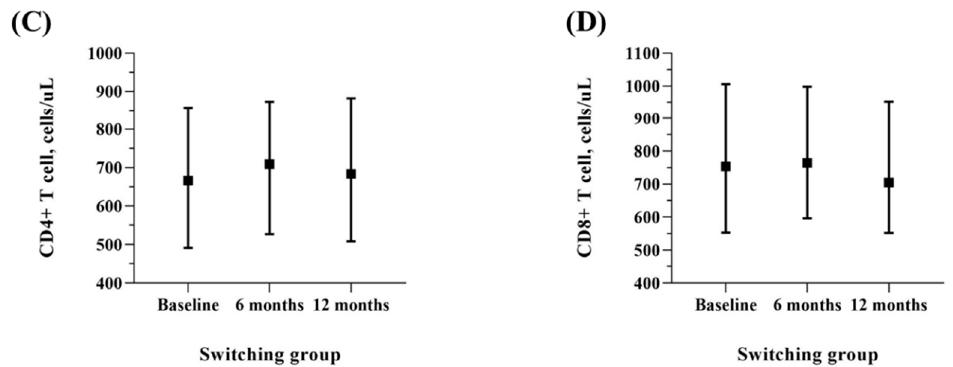
Figure 3. CD4+ and CD8+ T cell counts at baseline and 6- and 12-month follow-up after DTG/3TC